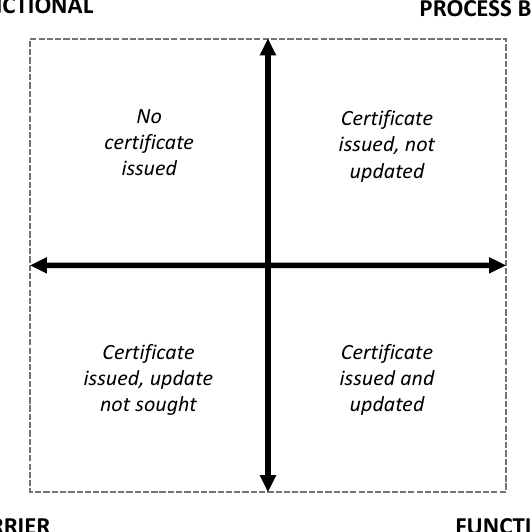
Figure 1. Heuristic Utilized for Categorizing Land Certificate Updating System. 147